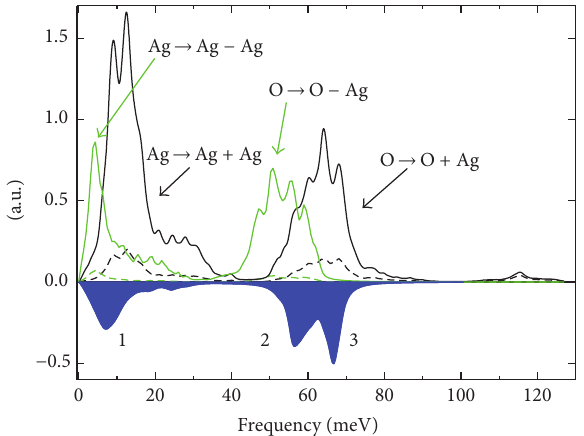
Figure 6: The TDOS spectra of Ag 2 O, 𝐷(𝜔) , at 40 K (dashed) and 400 K (solid). The downconversion and upconversion contributions are presented separately as black and green curves, respectively. The phonon DOS spectra are presented along with the TDOS but take a negative sign and shaded blue to make the view of TDOS and DOS